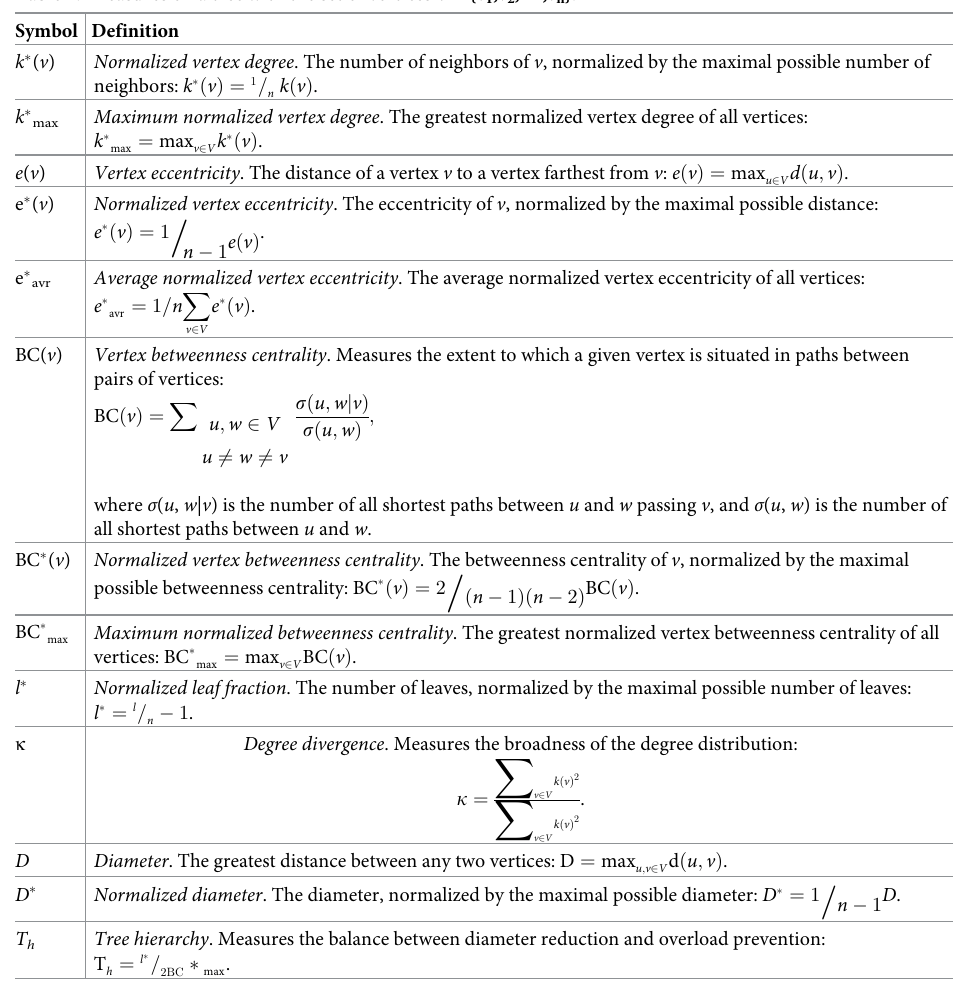
Brain graph topology. For each frequency band between-group differences in ^ C w ; ^ L w , and S were tested using a permutation test. The value used for significance was set to P < 0.05 and a correction for multiple comparisons over the three measures was performed by the false discovery rate [43].